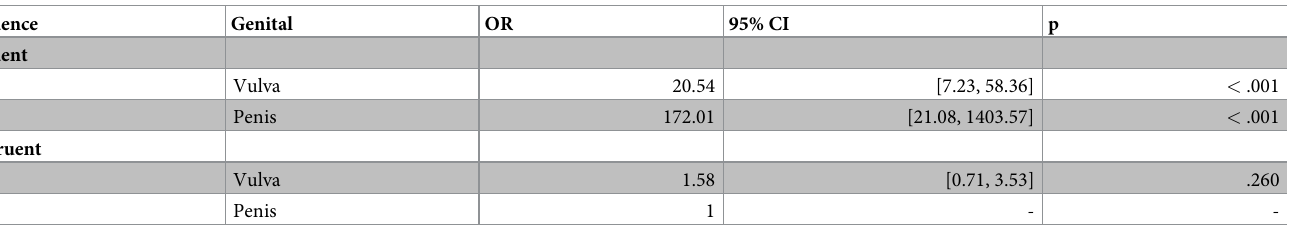
Table 3. Influences on subjective